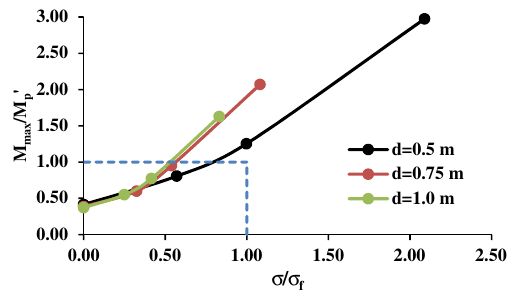
Fig. 20 Bending-buckling interaction graph of various diameter piles in RCD soil due to the scaled IMV